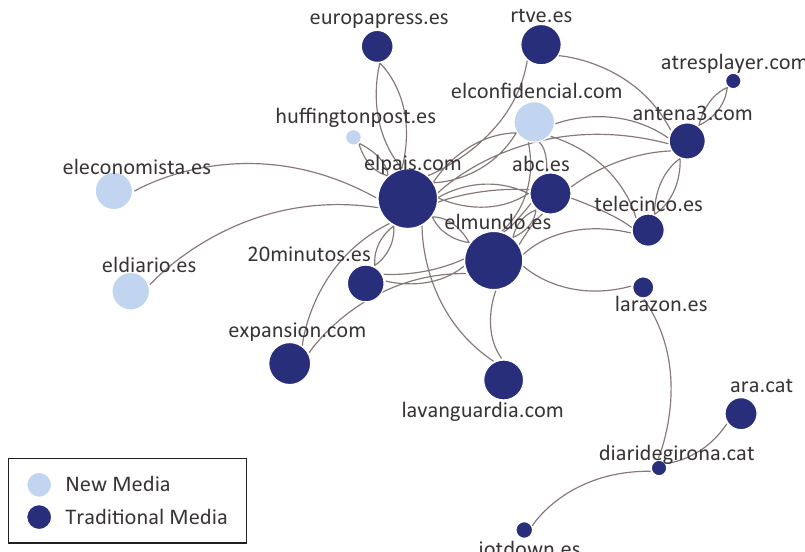
Figure 3. Audience brokers in the young audience network. age groups. According to our results, three digital- born outlets are playing the role of top brokers for young audiences: Elconfidencial.com , Eldiario.es and Eleconomista.es . Figure 3 maps their positions within the strongest connected component, i.e., the central part of the young audience network. The figure shows the most important brokers. Here, nodes represent news me- dia outlets and their size is proportional to their bro- kerage power. To obtain the strongest connected com- ponent of the structure, we have iteratively removed the weakest connections of the young audience net- work, a process known as percolation in network science (Borge-Holthoefer & Gonzalez-Bailon, 2015). The advan-